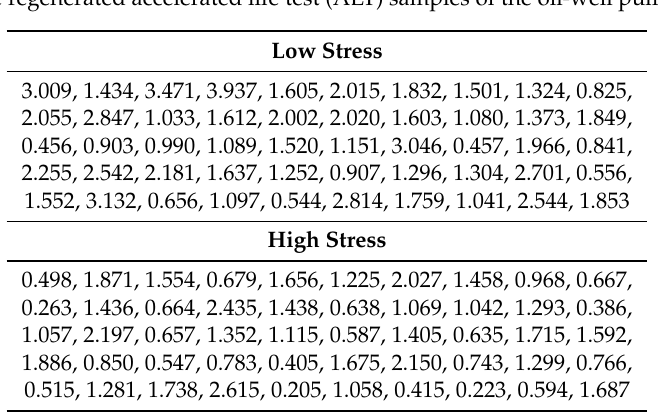
Table 4. The regenerated accelerated life test (ALT) samples of the oil-well pump